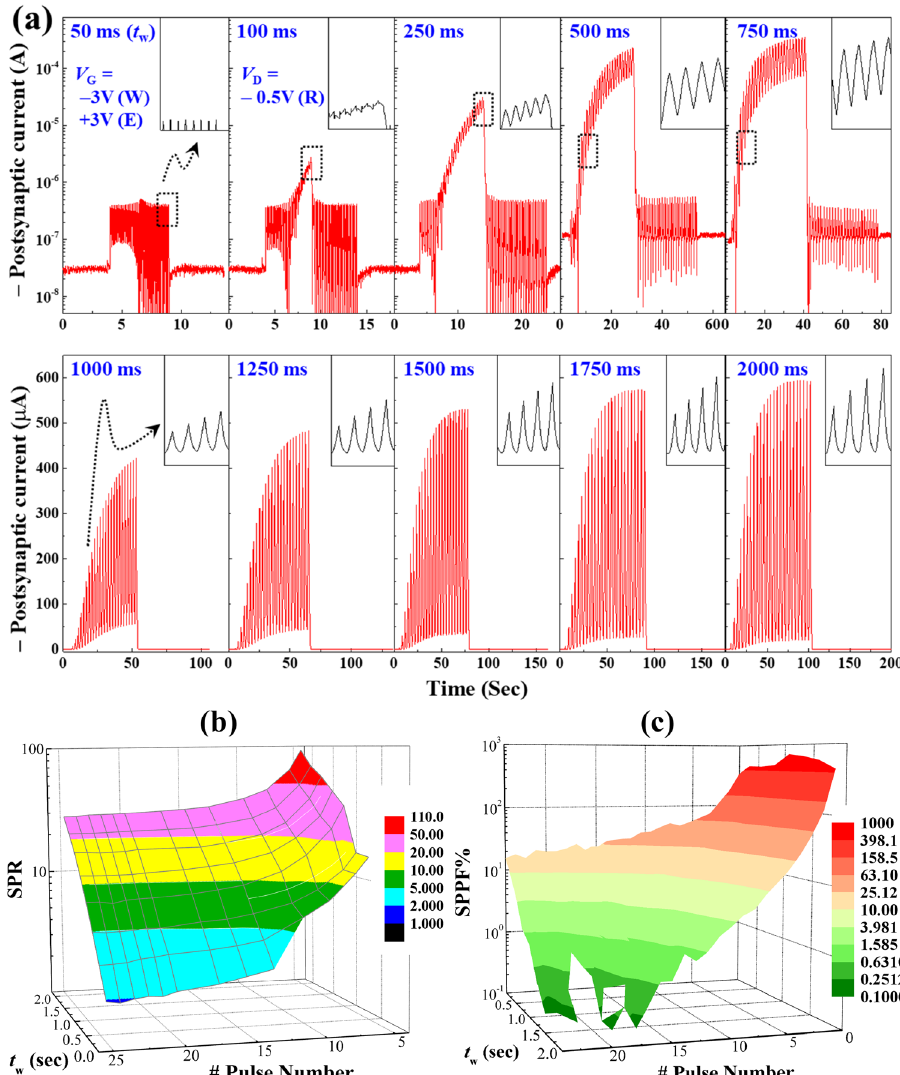
Figure 3. ( a ) Presynaptic pulse width ( t w ) dependent variation of the EPSC response to demonstrate spike- width-dependent plasticity (SWDP). 25 write pulses (− 3.0 V) followed by 25 erase pulses (+ 3.0 V) were consecutively applied at the gate by varying t w from 50 to 2000 ms. Insets, enlarged portion of the obtained curves to show the potentiation of EPSC for each of the incoming pulses. ( b ) Variation of the synaptic potentiation ratio (SPR) calculated from the two consecutive write (W) pulses for every pulse widths as obtained in ( a ). ( c ) Dependency of the sequential paired-pulse facilitation (SPPF) of synaptic weight on pulse widths and numbers as estimated from the results shown in ( a